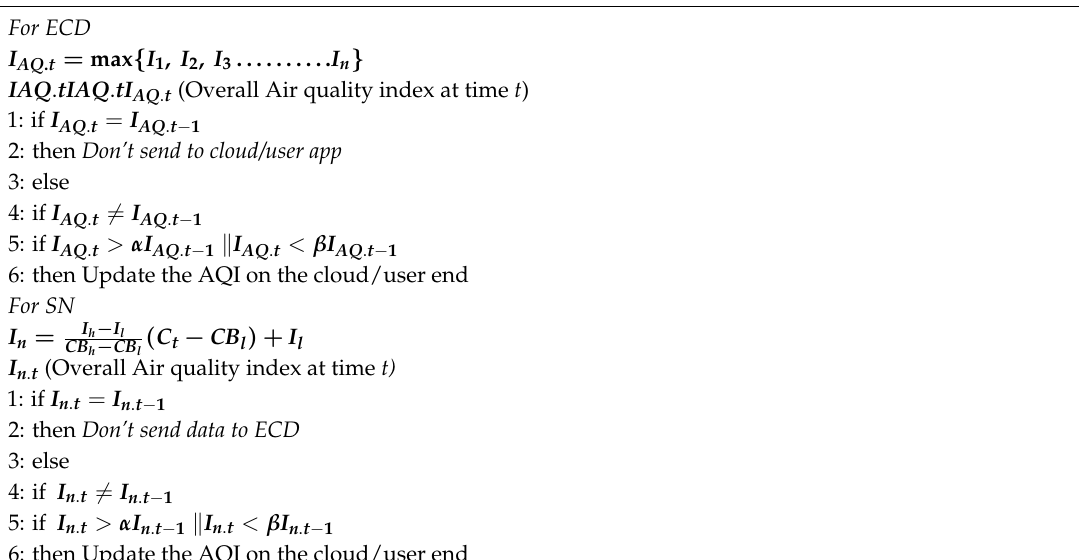
Algorithm 4: Data Transmition Strategy for ECD and SN For